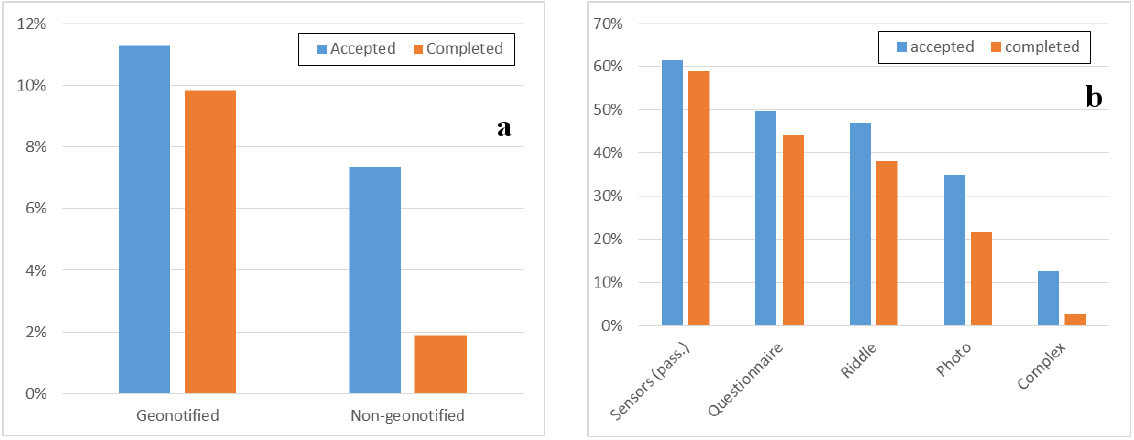
Figure 9. Acceptance ( a ) and completion ( b ) rate for different types of